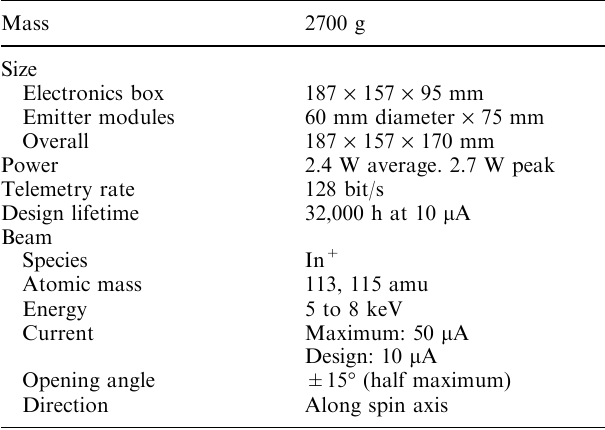
Table 1. Parameters of the instrument